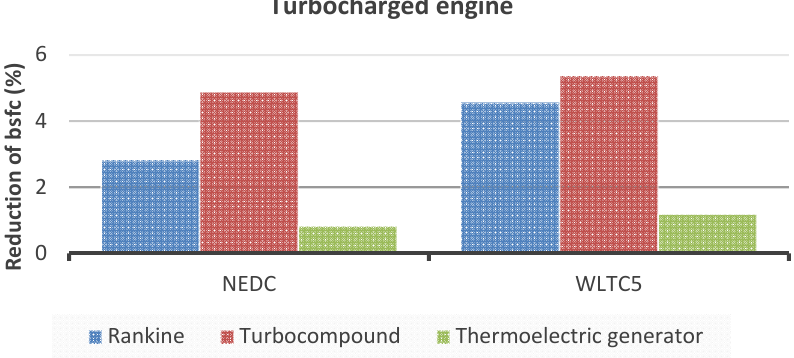
Figure 9. Reduction of fuel consumption for a turbocharged